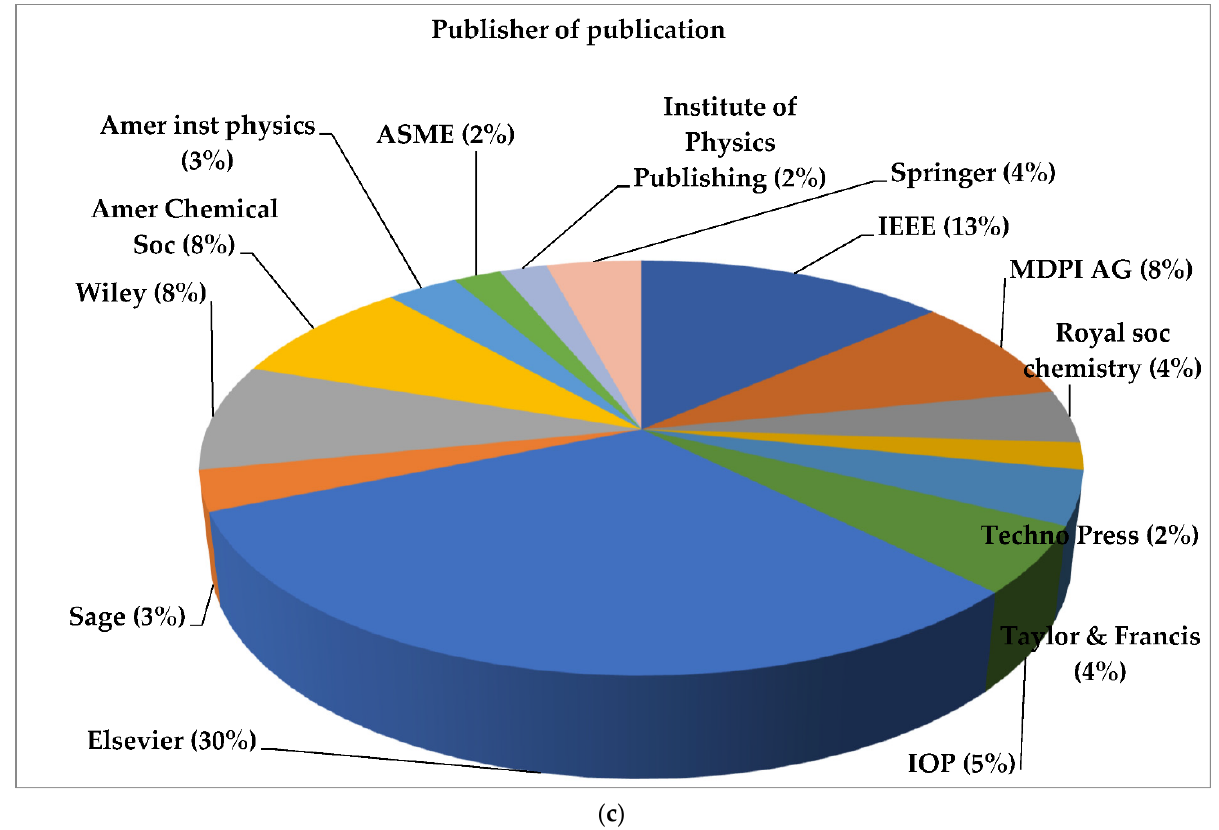
Figure 7. Articles for ( a ) journal analysis, ( b ) impact factor, and ( c ) publishers.